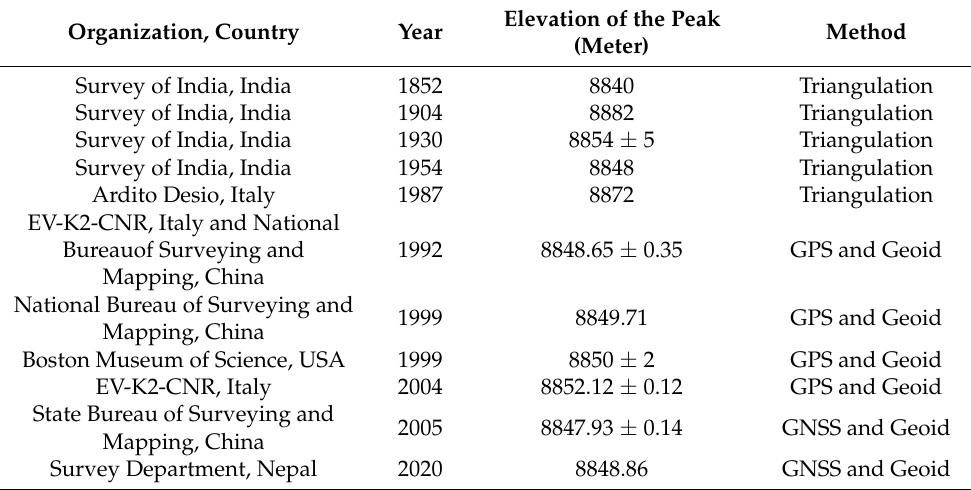
Table 1. The elevation of Mount Everest peak with the geoid ellipsoid separation N (geoid ellipsoid separation in meters) from different authorities, modified from the work of